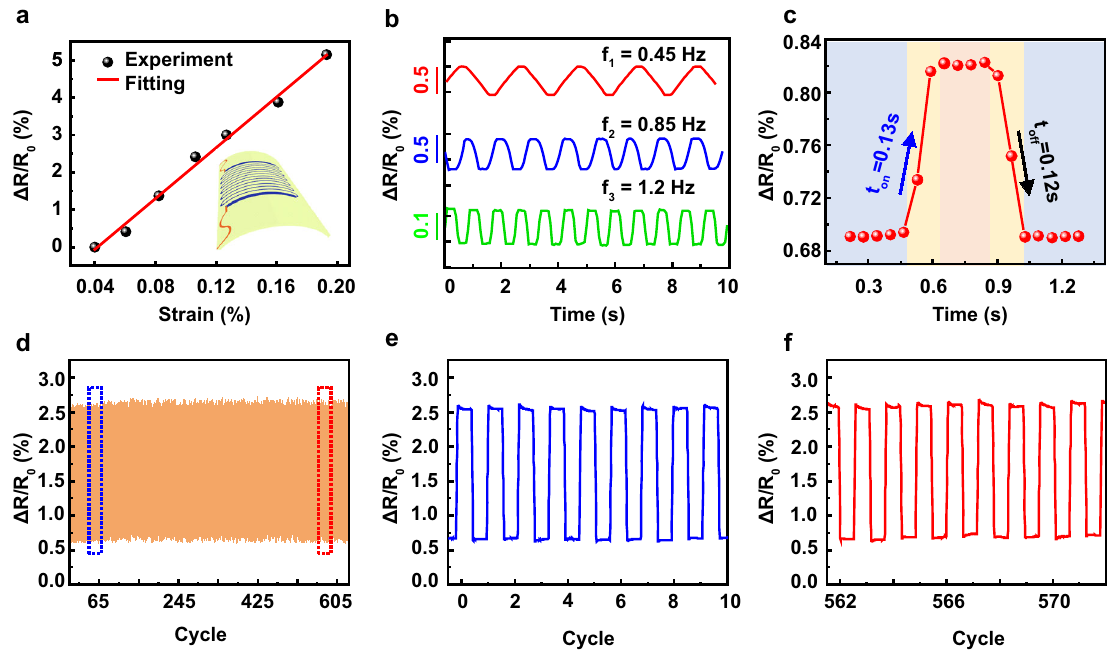
Fig. 4 Evaluations on the strain response of the fabricated sensor. a Experimental (black dots) and fi tted (red line) changes in the resistance at different bending strains. b Real-time resistance variations of the sensor responding to cycling bending operations with different frequencies. c A magni fi ed period of the resistance variation under cycling bending with the frequency of 1.2 Hz, and the response time to in fl iction and release of the bending strain is 0.13 s and 0.12 s, respectively. d Stability demonstration of the sensor responding to the cycling bending operation more than 600 cycles. e, f Magni fi ed results of resistance variations obtained from the result displayed in d highlighted with dotted blue and red